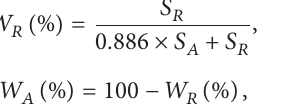
/perlite composites and 2 component with respect to the total 2